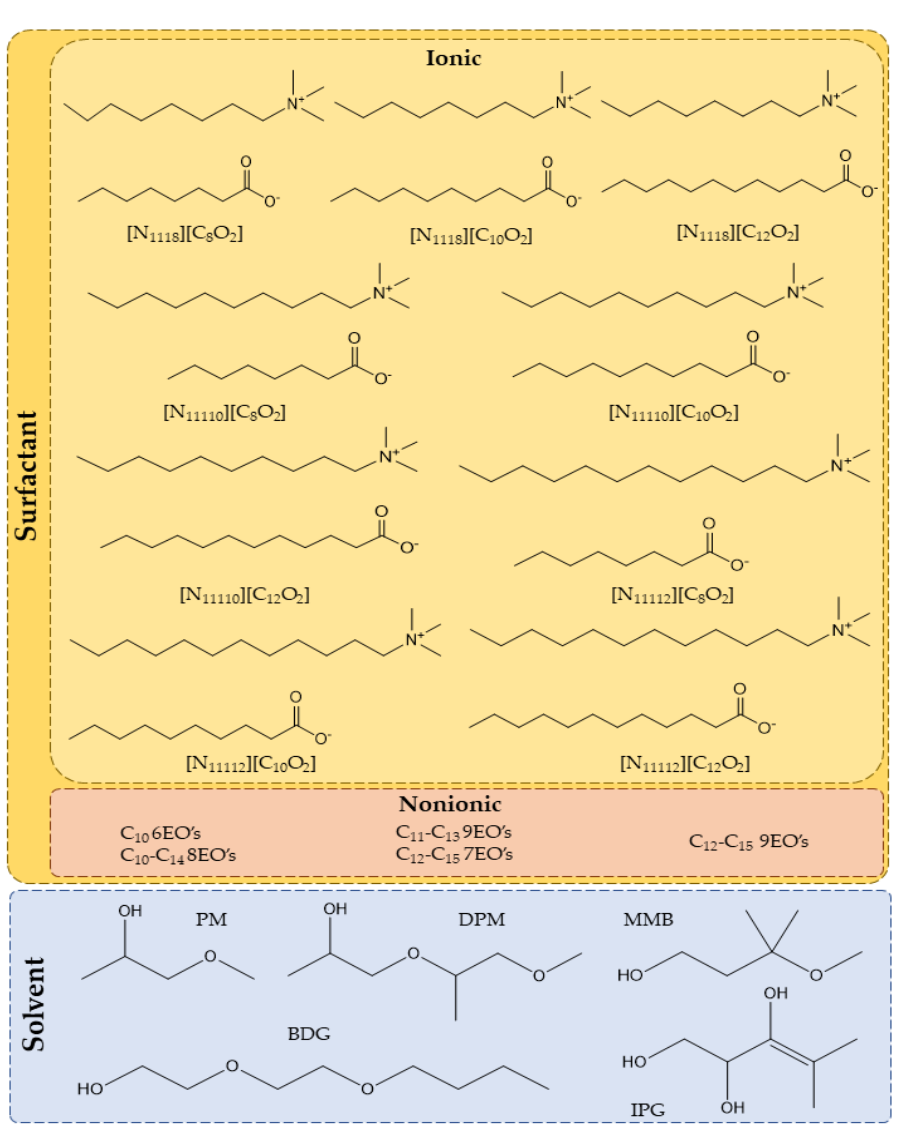
Figure 10. Chemical structures of solvents and surfactants used in the development of degreaser formulations.